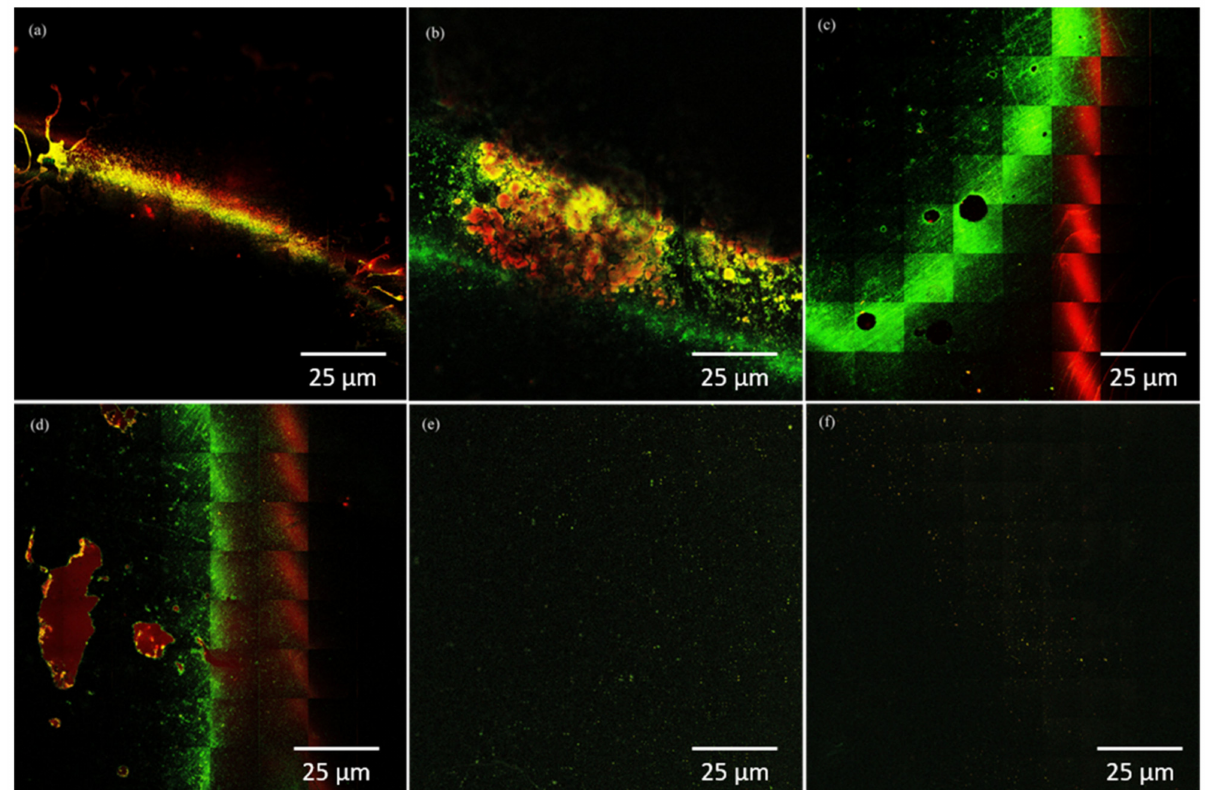
Figure 2. Photon images of biofilms of different microorganisms formed on the surface of dental porcelain IPS Inline incorporated with β -AgVO 3 , acquired by a multiphoton microscope. Green: viable cells (live); red: non-viable cells (dead). ( a ) Streptococcus mutans biofilm on the surface of the control group; ( b ) S. mutans biofilm on the surface of the 2.5% group; ( c ) Streptococcus sobrinus biofilm on the surface of the control group; ( d ) S. sobrinus biofilm on the surface of the 5% group; ( e ) Aggregatibacter actinomycetemcomitans biofilm on the surface of the control group; ( f ) A. actinomycetemcomitans biofilm on the surface of the 2.5%